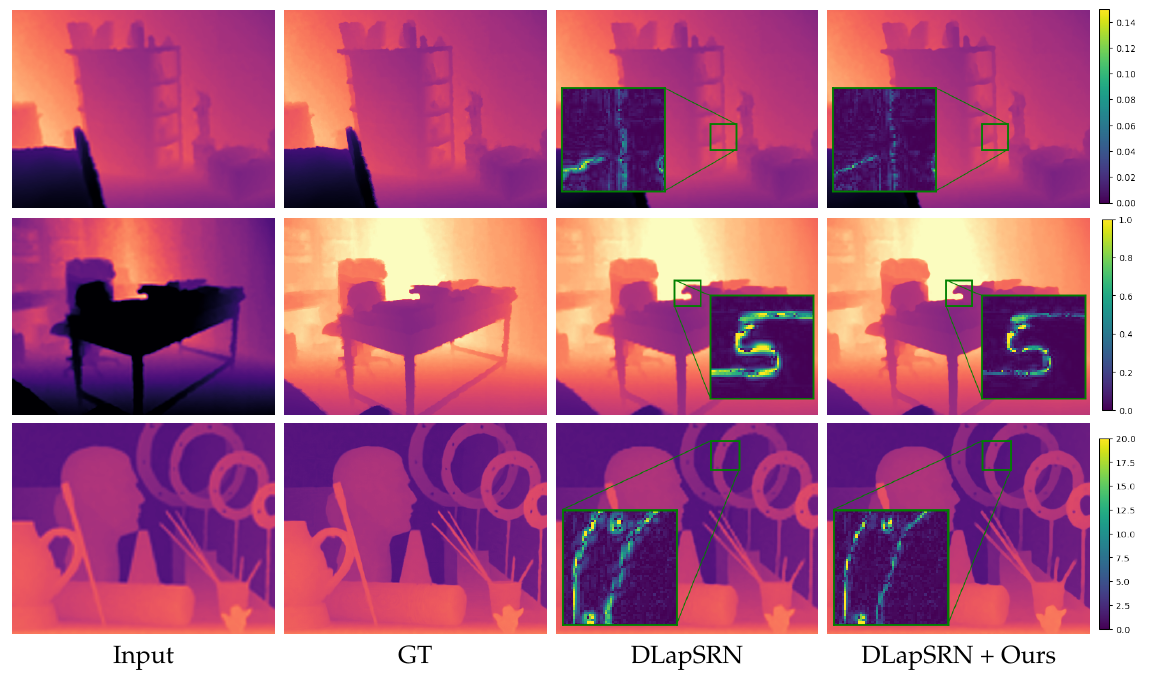
Figure 4. Depth-only super-resolution results. The input is upscaled for visualization purposes. Insets show absolute difference to ground truth. The first two rows are examples from the NYU v2 [33] test set and the third row from the Middlebury dataset [37].